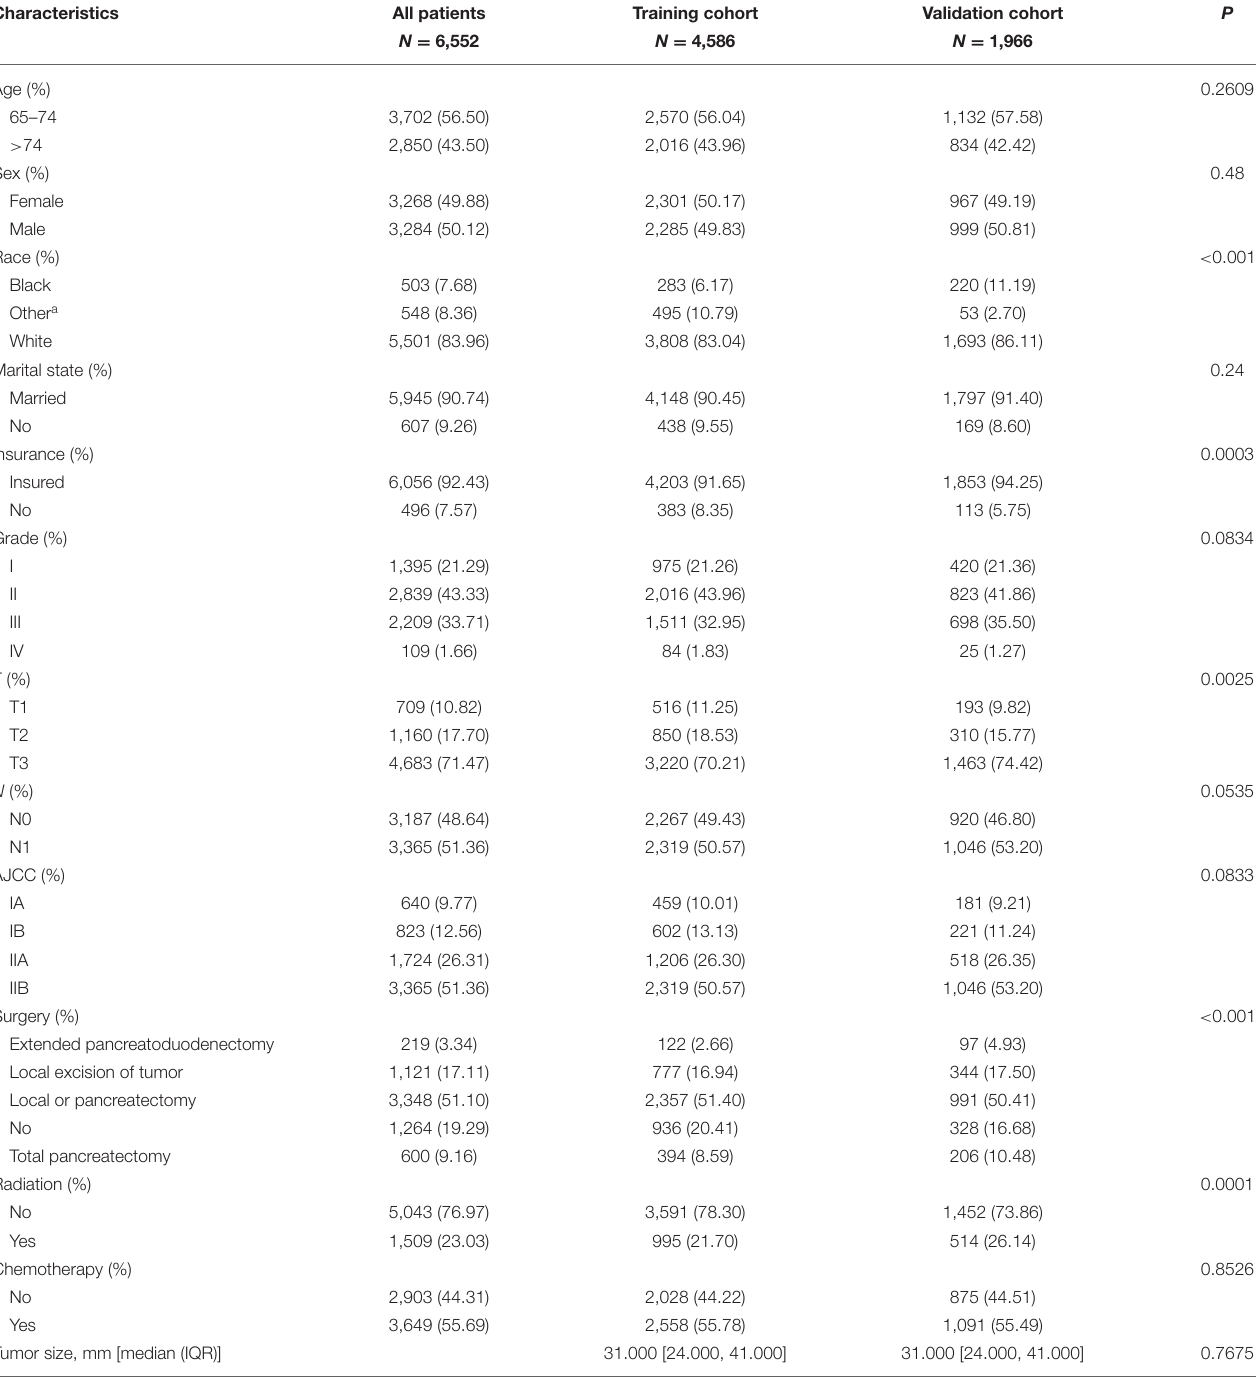
TABLE 1 | Demographical and clinical characteristics of training set and validation